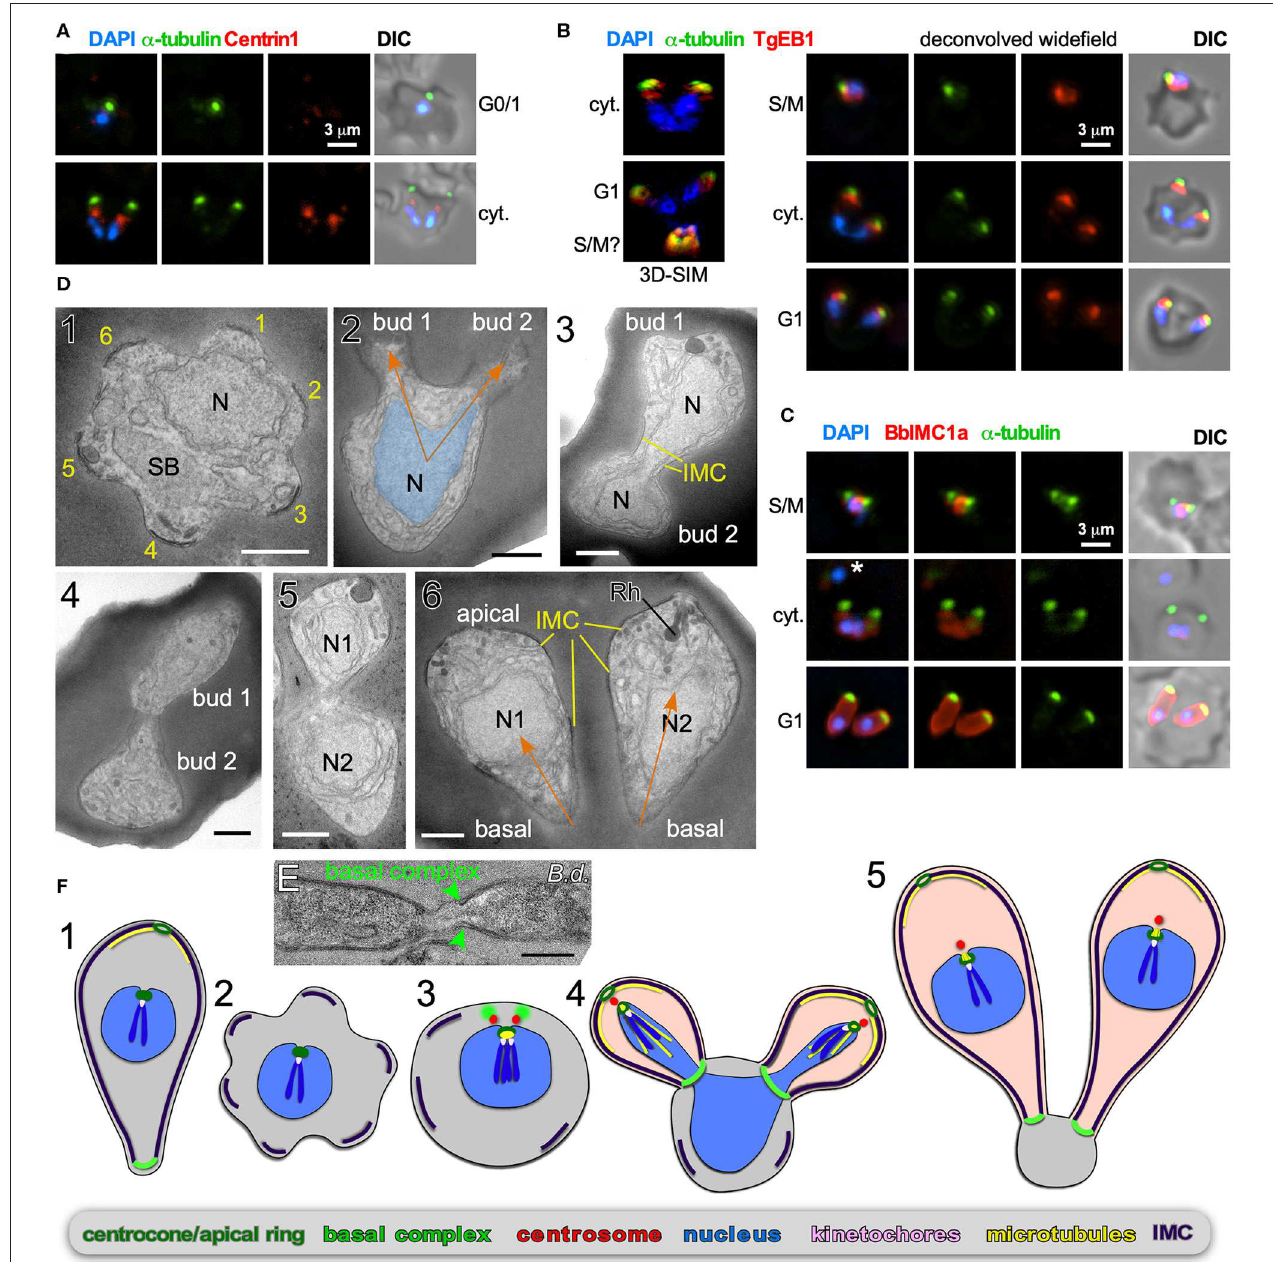
FIGURE 3 | Binary fission by Babesia spp. (A–D) Babesia bigemina iRBC stages. (A) Immunofluorescence using MAb α -tubulin 12G10 (green) and TgCentrin1(red) polyclonal antibody. Centrin staining is not observed in interphase (G1) while diffuse and weak during cell division (cyt.). (B) Immunofluorescence using MAb α -tubulin 12G10 (green) and microtubule ( + )-end binding protein TgEB1 polyclonal antibody (red) demonstrates that the cortical microtubules are relatively short and do not reach the nucleus. (C) Immunofluorescence using polyclonal guinea pig BbIMC1a antiserum (see Figure S1 for validation) and MAb α -tubulin 12G10 shows the IMC is present during G/M, outlines budding daughters (cyt.), and extends along the length of the mature G1 parasites. *Marks a recently invaded parasites wherein the cytoskeleton is completing disassembly; we observed many trophozoites without detectable PbIMC1a. (D) Transmission electron microscopy of progressive iRBC developmental stages (1 → 6). Panel 1 is a disassembling merozoite already escaped from the vacuole displaying typical pattern of six numbered remnants of the disassembling mother IMC. Panel 2 represents early daughter formation (“Mickey Mouse”) with the nucleus being separated into the daughter buds. Panels 3–5 represent different sections though developing daughters where showing parallel assembly (in contrast to polar assembly) consistent with the angle under which the daughter buds assemble. Panel 6 displays two just divided daughters under the typical angle. N, nucleus; SB, spherical body. Yellow marks IMC; orange arrows mark the typical angle and direction of daughter buds. Scale bars represent 500nm. (E) Babesia divergens basal complex upon completion of cell division. Scale bar represents 500nm. (F) Schematic of apicomplexan asexual cell division by binary fission, which mechanistically represents a binary form of schizogony. Note that the mother’s cytoskeleton is largely disassembled following successful host cell invasion resulting in a pleomorphic cell (2), but that fragments of the IMC are remaining throughout the division stages (2–4).